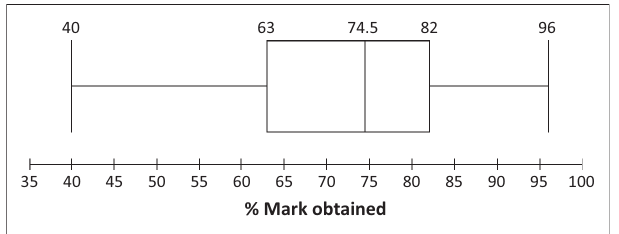
FIGURE 2: Box-and-whisker plot of the overall